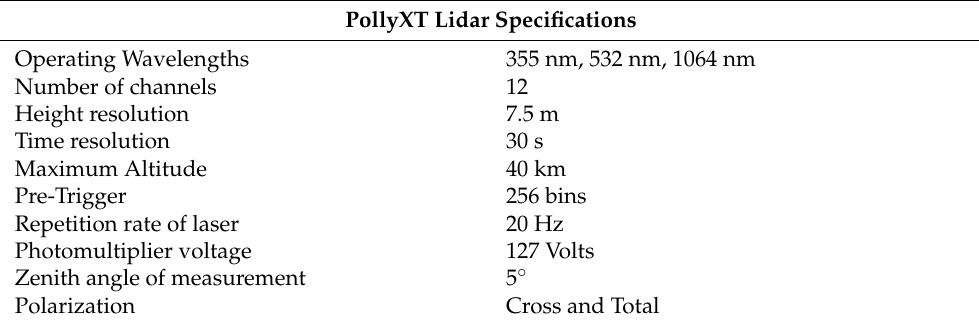
Table 1. Specifications of PollyXT Raman Lidar, more information at [28].